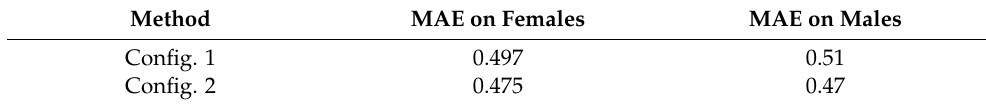
Table 8. MAE under perfect maturity stage classification.